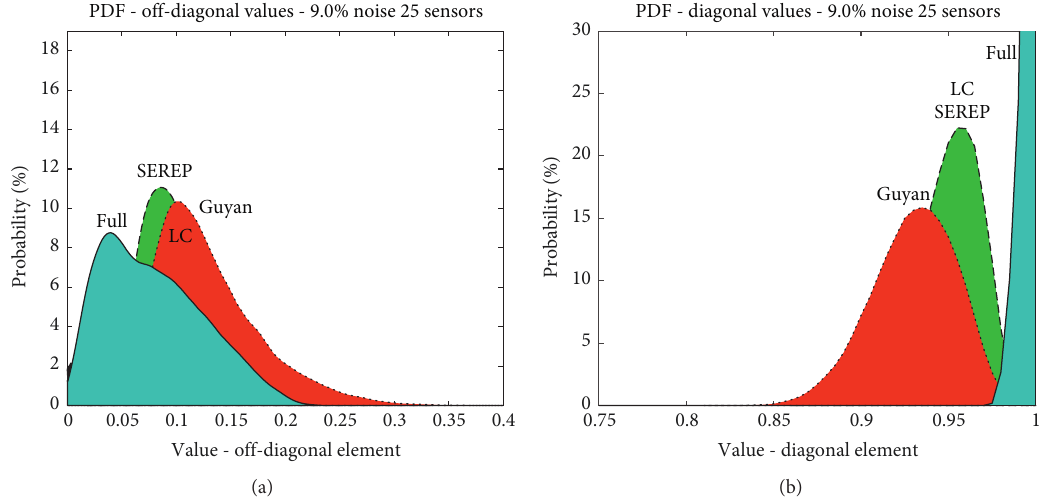
Figure 11: (a) PDFs of the maximal off-diagonal elements. (b) PDFs of the minimal diagonal elements. Both with 9 pct. Noise on the modes and 25 sensors.